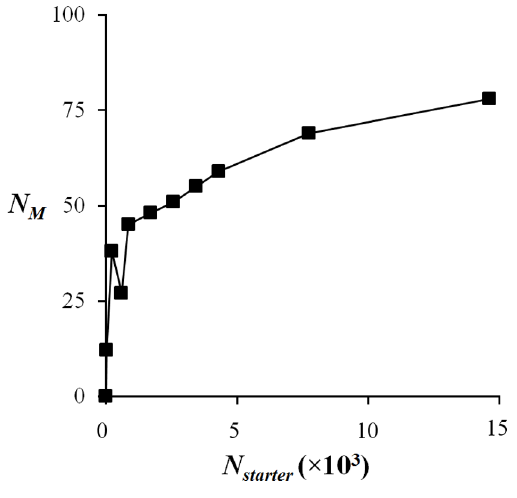
Figure 1. Iterative signature algorithm (ISA) module genera- tion analysis. Number of iterative signature algorithm (ISA) modules N M as a function of the number of starter gene sets, N starter .